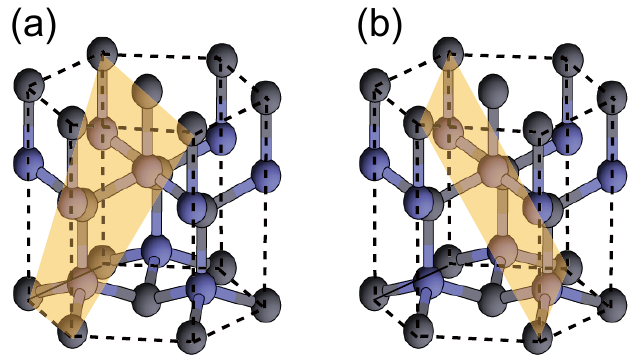
Figure 14. Crystal plane schematics for semipolar ( a ) (cid:4666)11(cid:3364)01(cid:4667) and ( b ) (cid:4666)112(cid:3364)2(cid:4667)